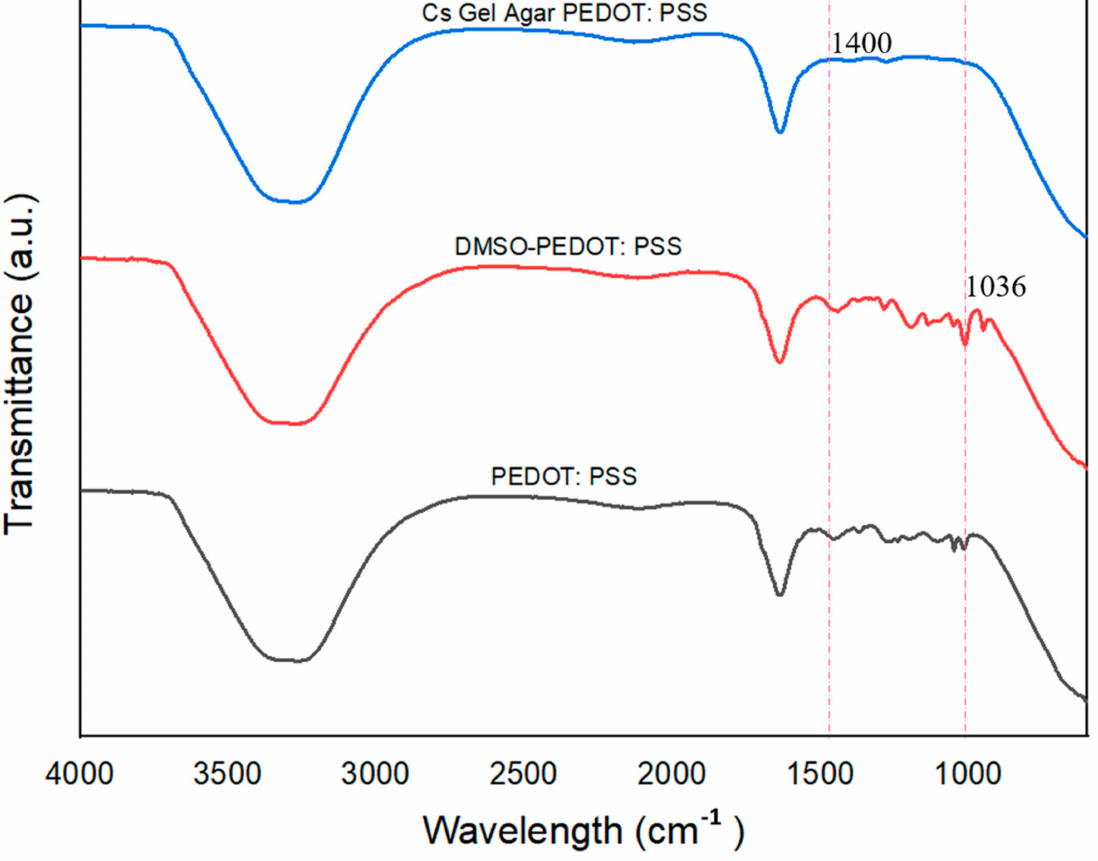
Figure 11. The ATR-FTIR plots of pure PEDOT: PSS, PEDOT: PSS-doped DMSO and Cs–Gel–Agar–PEDOT